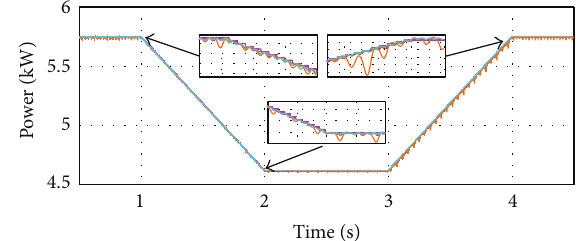
Figure 13: Maximum power extracted and theoretical power during a fluctuation in solar radiation from 1000W/m 2 to 800W/m 2 .